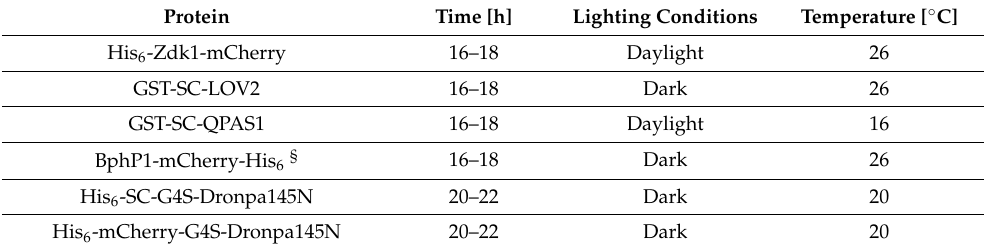
Table 1. Expression conditions for the photo-switchable proteins.